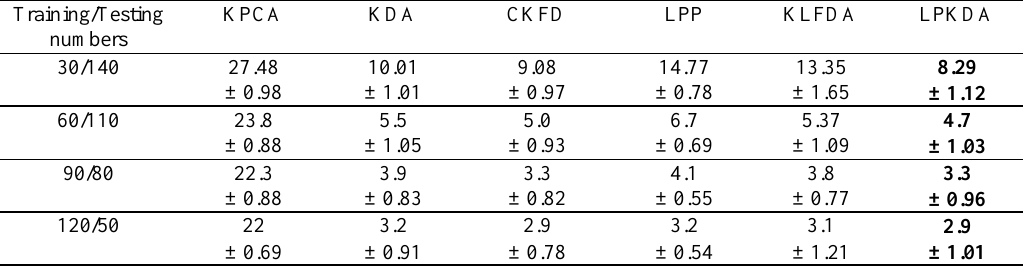
Table 5. The average error rates (%) across 10 tests and their standard deviations (std) on PIE database.